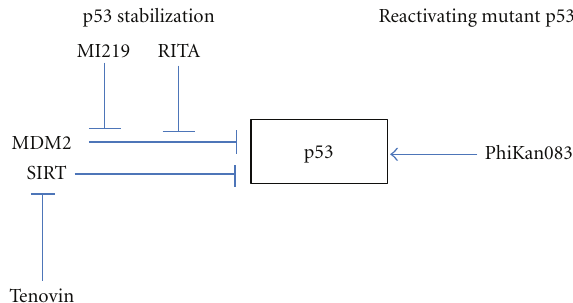
Figure 2: Strategies for p53 stabilization and reactivating mutant